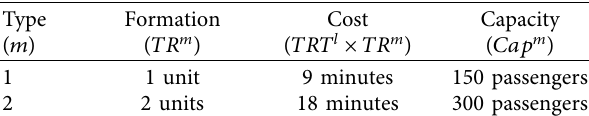
Table 10: The train formation parameters.